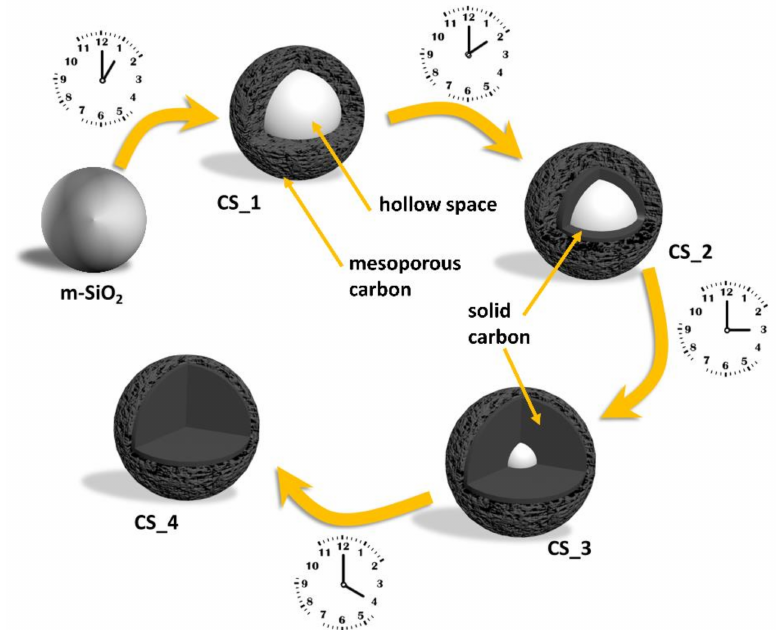
Figure 1. Scheme presenting the change in morphology of resulting carbon spheres after 1 h (CS_1), 2 h (CS_2), 3 h (CS_3) and 4 h (CS_4) of chemical vapor deposition